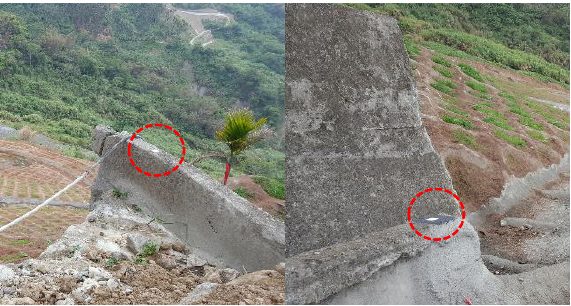
Figure 8. Photogrammetric target examples (MTP63 & MTP64) In this paper, two measurement results obtained from April 19 and June 30 are compare. Their displacement vectors are plot at Figure 9 and Figure 10 for horizontal and vertical directions, respectively. In which, one may observe two points that have very large displacement on both directions. They are named MTP63 and MTP64 as shown in Figure 8. Because of heavy rainfall and their locations are close to the landslide area, we obtain a horizontal displacement with 1.27 m and 0.99 m together with 0.89 m and 0.6 m of vertical offset. The other photogrammetric points also have small displacement, but not significant. GNSS stations with lower cost.